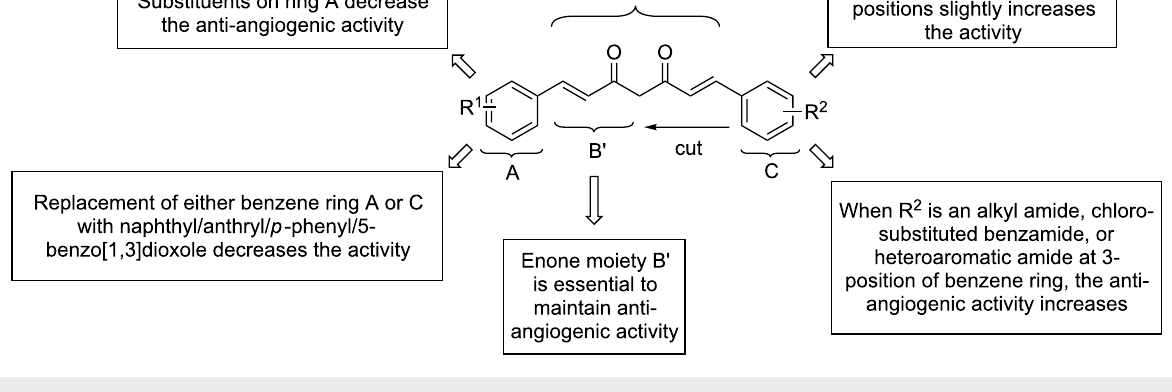
Figure 2: Structure–activity relationship of curcumin analogs.